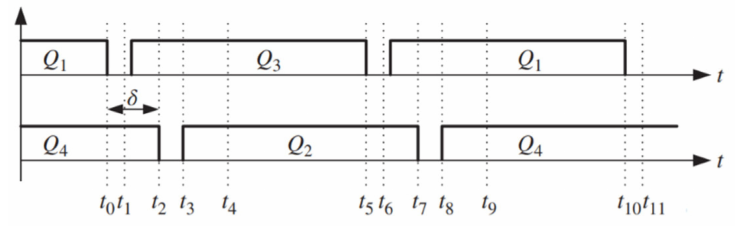
Figure 3. Example signal waveform of